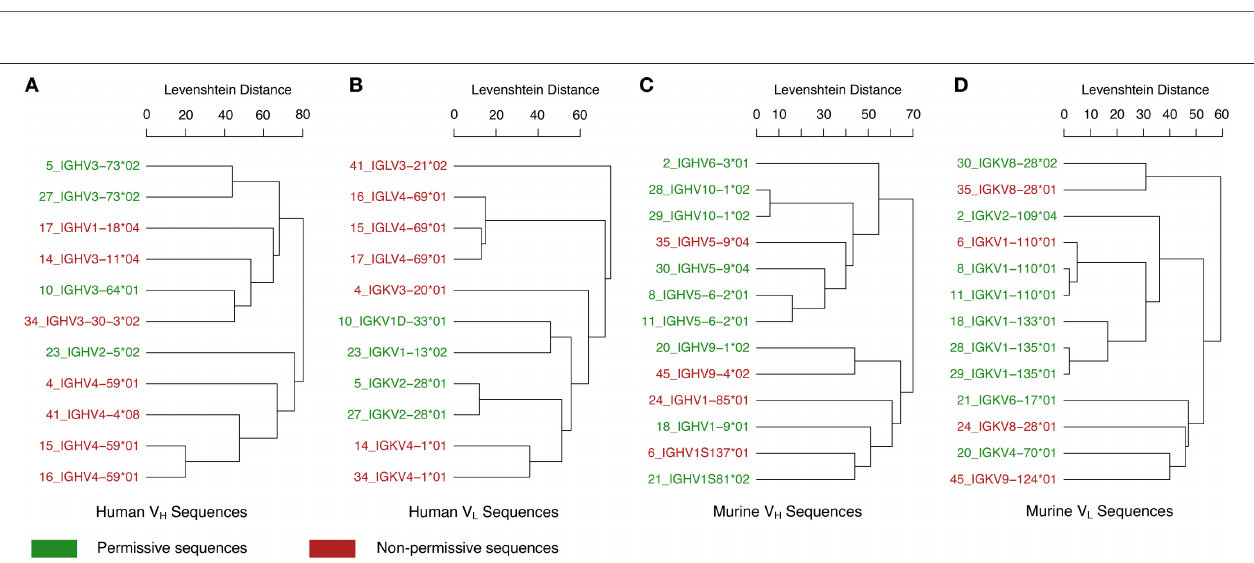
FIGURE 2 | Relationships between permissive and non-permissive V region sequences. Immunoglobulins with differing C regions and identical V regions were identified in the literature ( Table 2 ). VH and VL amino acid sequences were found for 24 of these unique antibodies (11 human and 13 murine, Table 2 ). Human sequences were grouped by (A) VH and (B) VL sequences. Murine sequences were also grouped by (C) VH and (D) VL sequences. For each group, a dendrogram was constructed through hierarchical average-linkage clustering with pairwise sequence similarity calculated as the Levenshtein distance. Leaf labels in the dendrograms are colored according to whether changes in the constant region for that antibody were permissive (green) or non-permissive (red) of specificity changes. The top V-region gene candidate for each amino acid sequence was determined with the IGBLAST blastp program using default parameters for either the human or mouse database (IGBLAST). Leaf labels in the dendrograms are of the form “seqID_top V-region gene hit,” where seqID matches the sequence ID given in Table 2 .